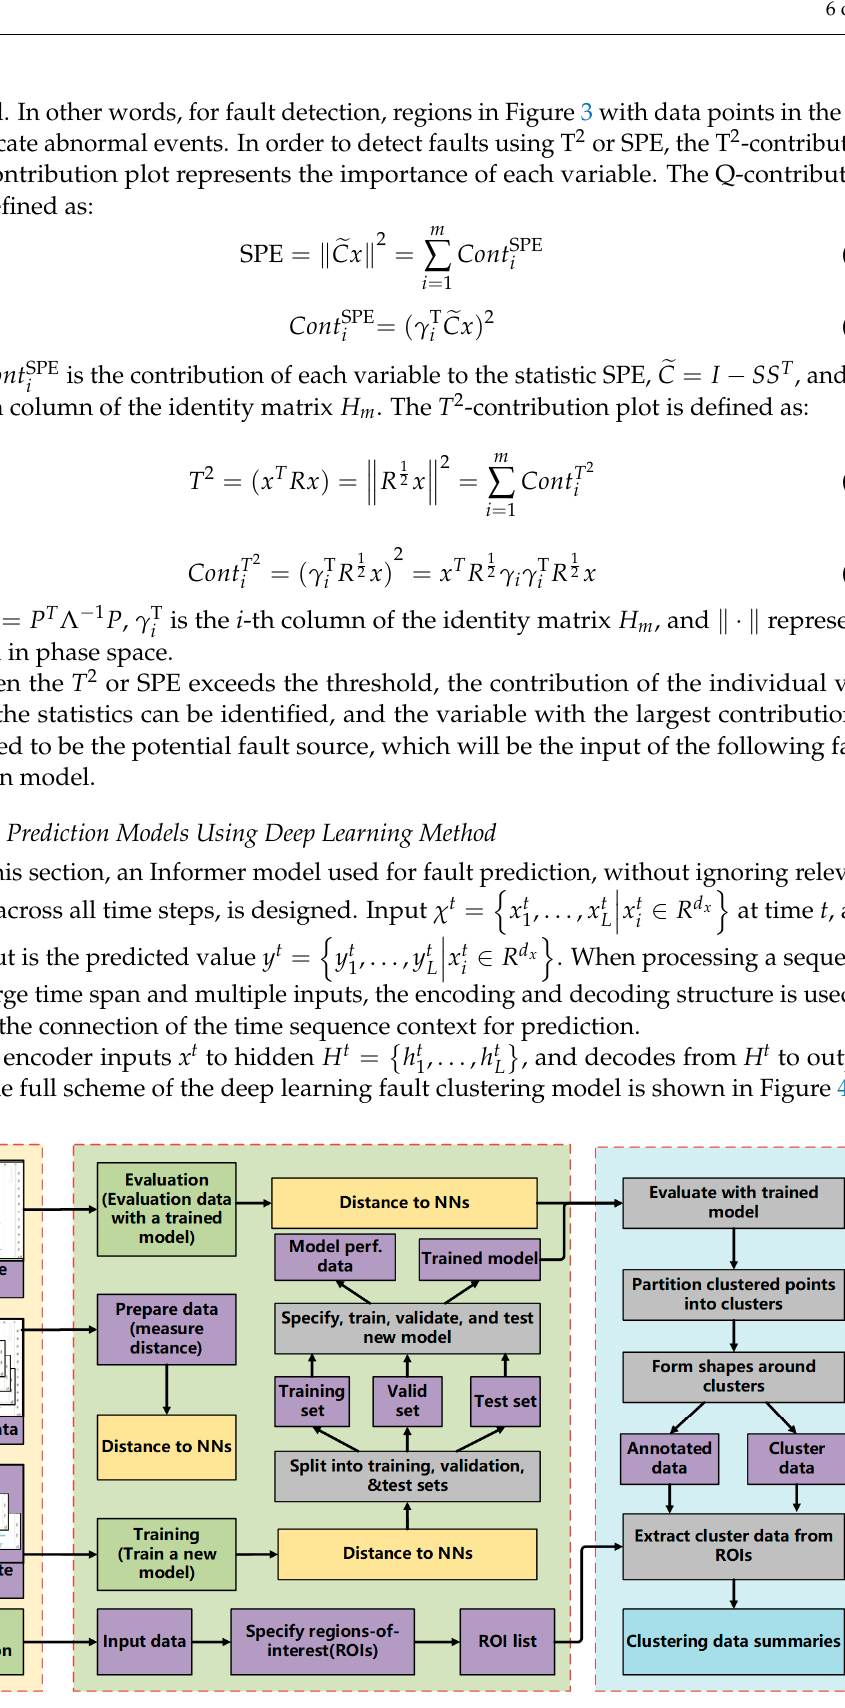
Figure 4. Deep learning fault clustering scheme.